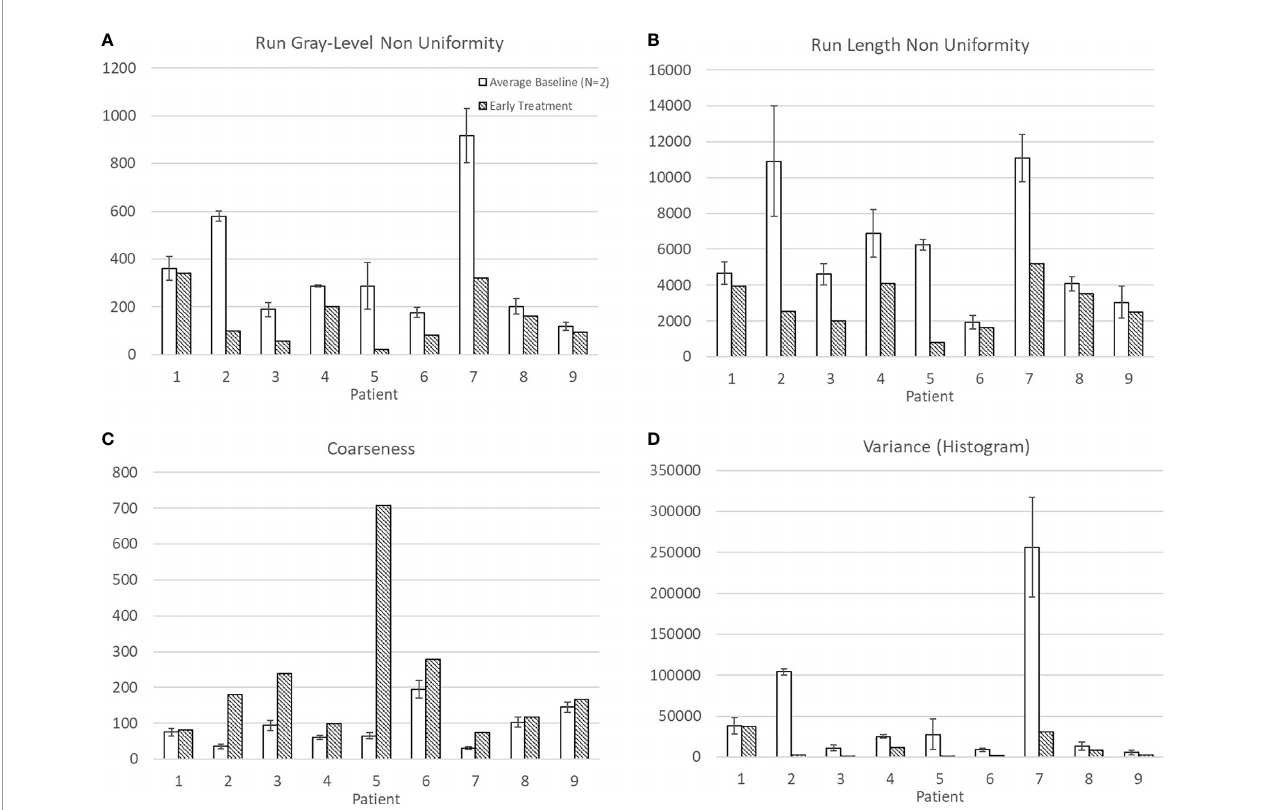
FIGURE 1 | Average and standard deviation for baseline 1 & 2 and early treatment features with statistically signi fi cant differences: (A) Run Gray-Level Non Uniformity, (B) Run Length Non Uniformity, (C) Coarseness, and (D) Variance